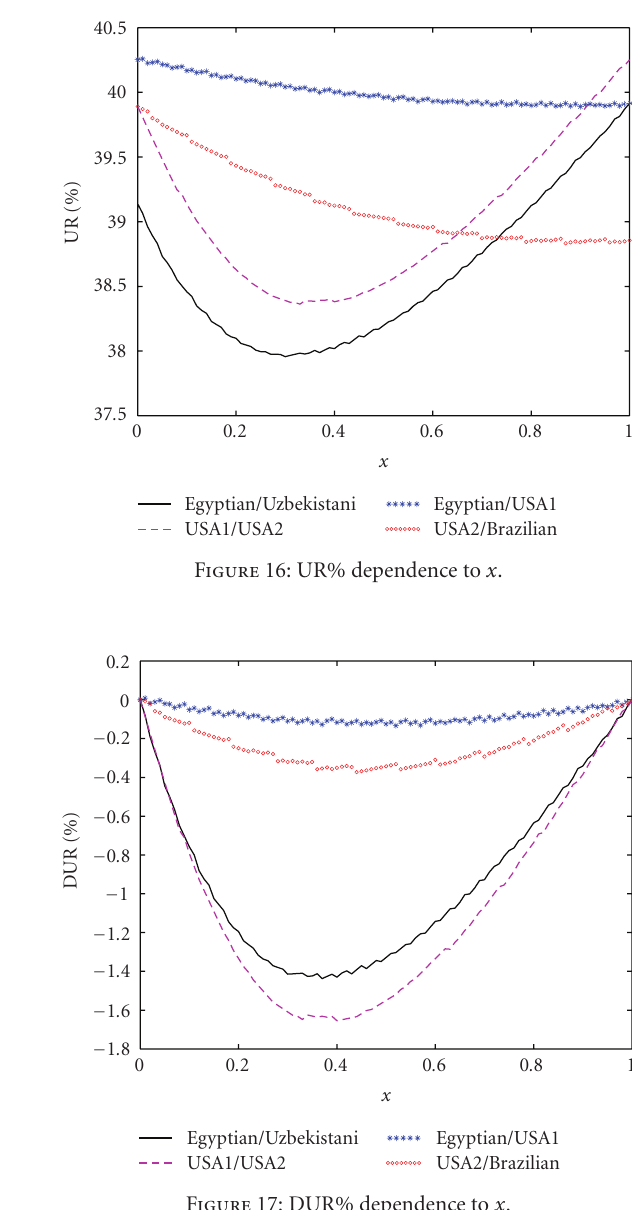
Figure 17: DUR% dependence to x